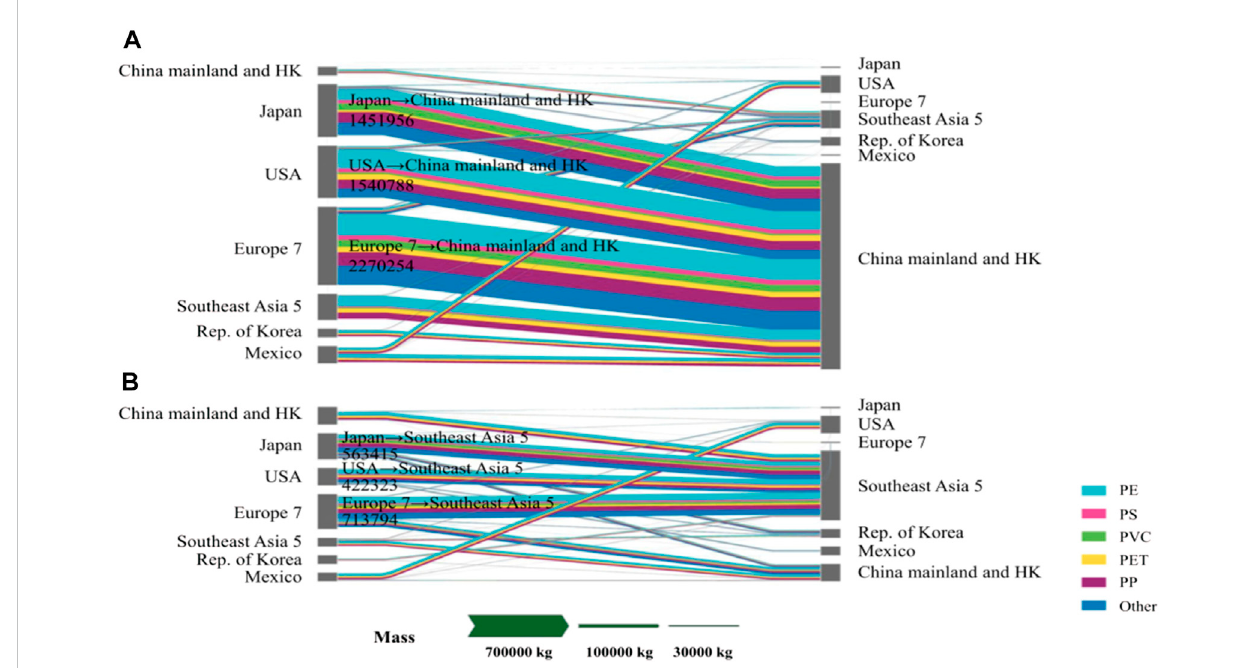
FIGURE 5 Trade fl ows of six types of plastic waste under two scenarios. (A) Global trade fl ows of six types of plastic waste prior to the ban (Baseline Scenario); (B) fl ows subsequent to the ban (2018 Scenario). The unit of the fl ows is tons (Wen et al.,